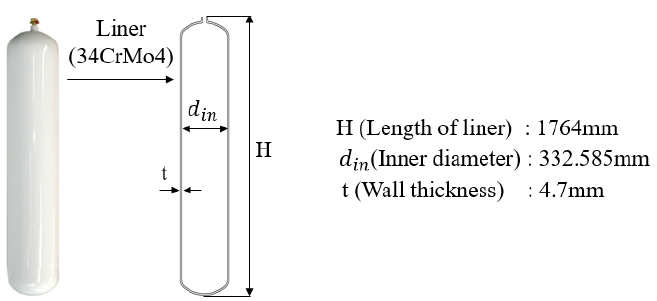
Figure 2. Dimensions of the liner for the type II CNG vessel.